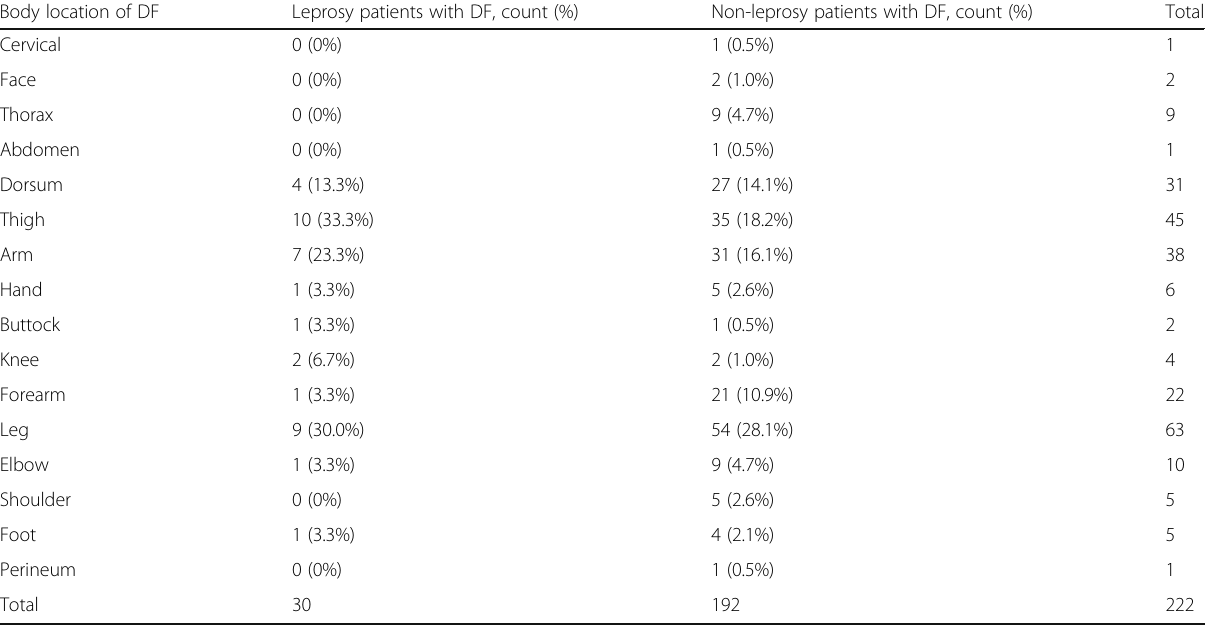
Table 1 Distribution of dermatofibromas (DF) in a sample of 222 patients with and without leprosy Body location of